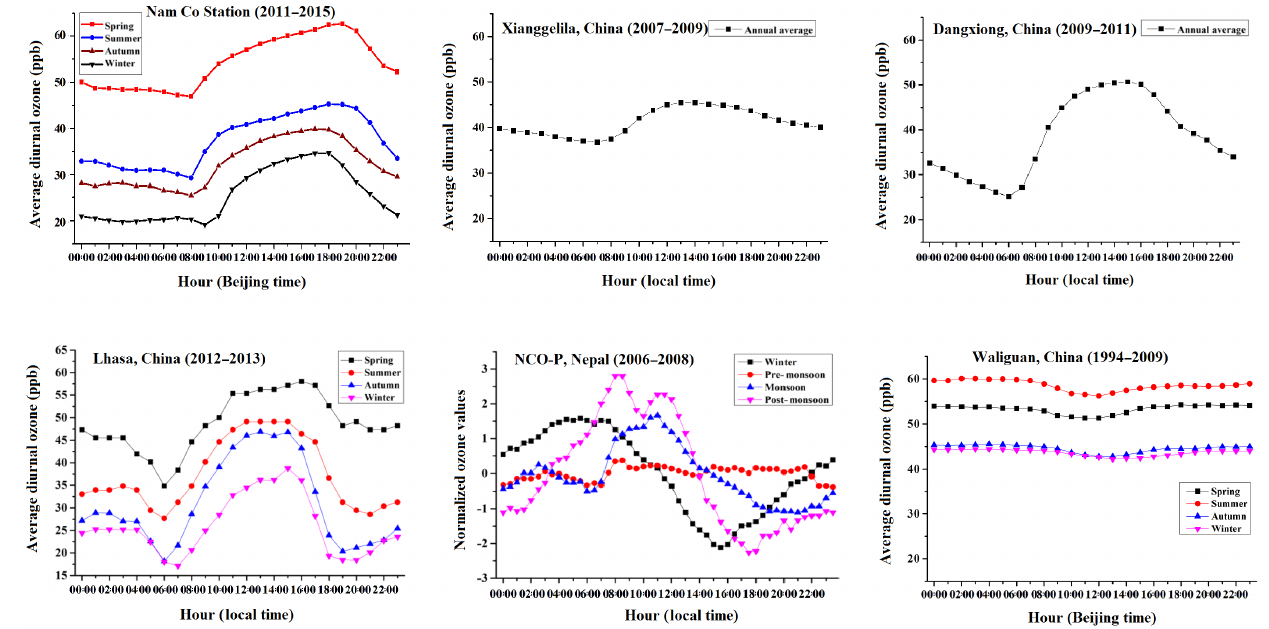
Figure 8. Comparison of diurnal profiles of surface ozone concentration at different sites in the Tibetan Plateau (based on Ma et al., 2014; Lin et al., 2015; Ran et al., 2014; Cristofanelli et al., 2010; Xu et al., 2011). Measurement years at different sites are displayed in